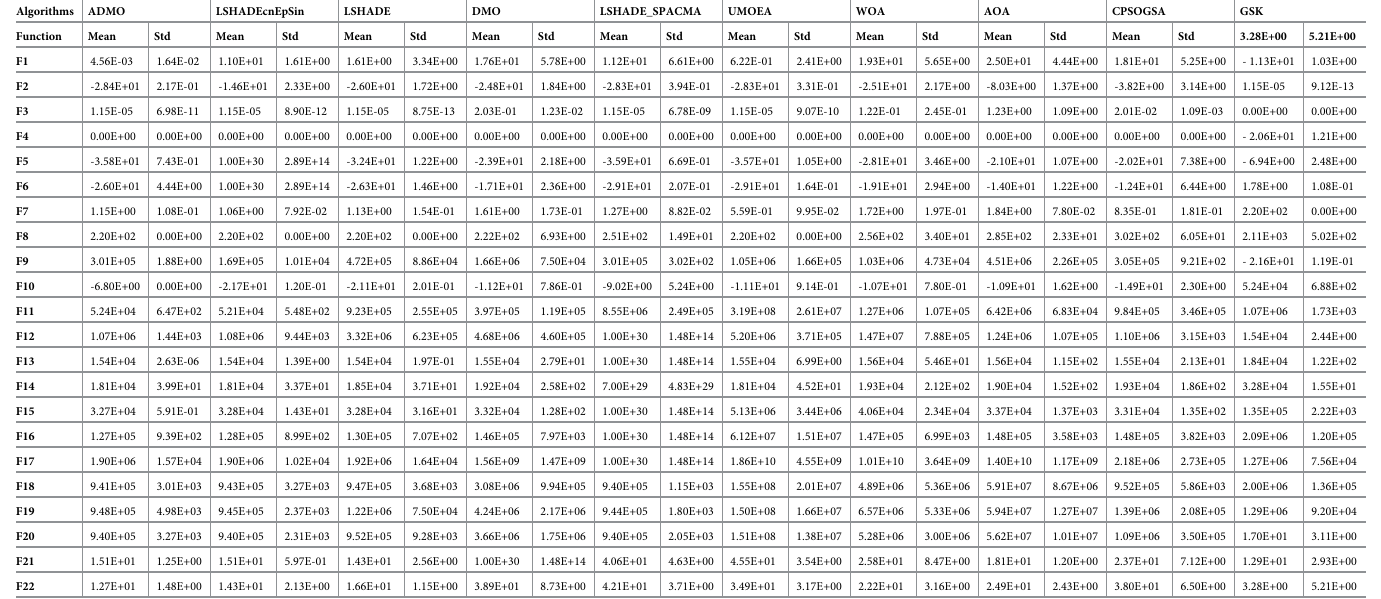
Table 17. Comparative results for CEC